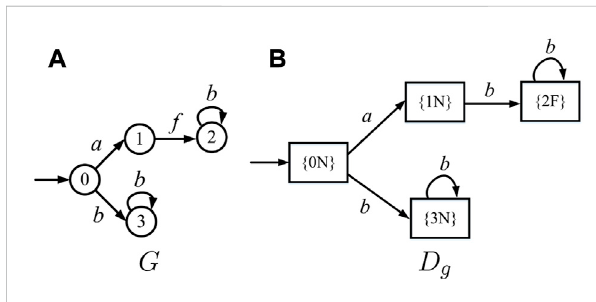
FIGURE 2 (A) Plant G and (B) diagnoser D g in Example 10.